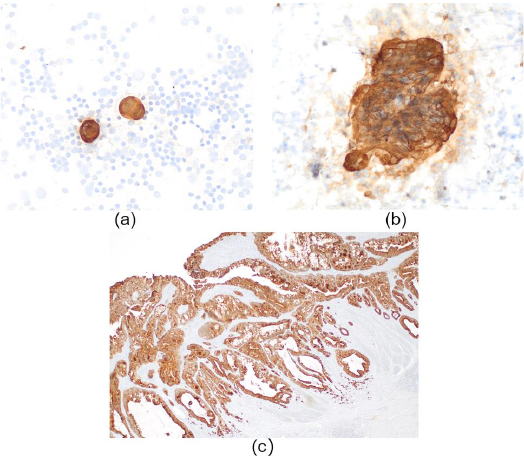
Figure 2. CK19 immunochemistry. ( a ) Positive CK19 immunocytochemistry stains of cytology smears from different lymph nodes showing few solitary tumour cells. ( b ) A group of positive tumour cells from a cytology smear. ( c ) A primary colorectal carcinoma positive for CK19 immuno- histochemistry.